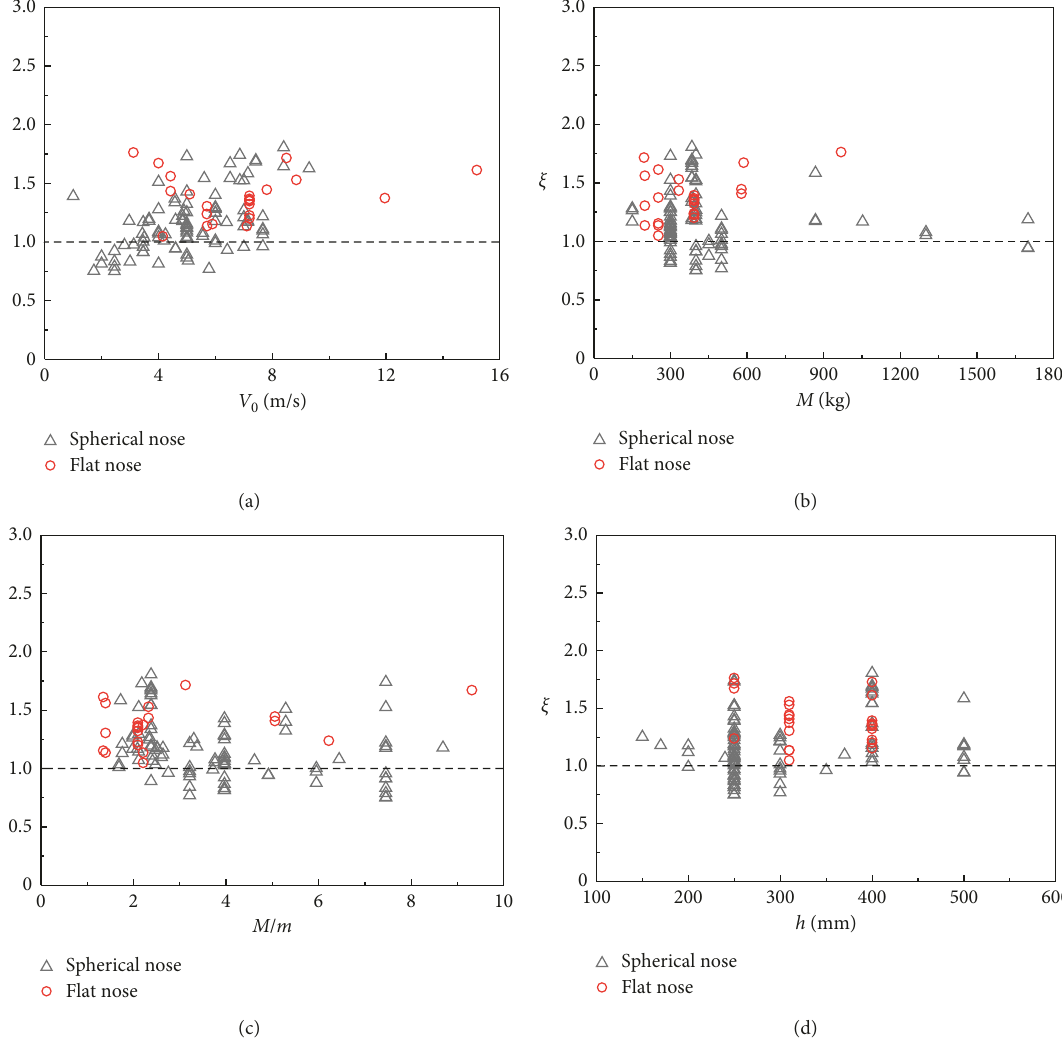
Figure 13: Influence of the main parameters on ξ . (a) Impact velocity. (b) Impact mass. (c) Mass ratio. (d) Section